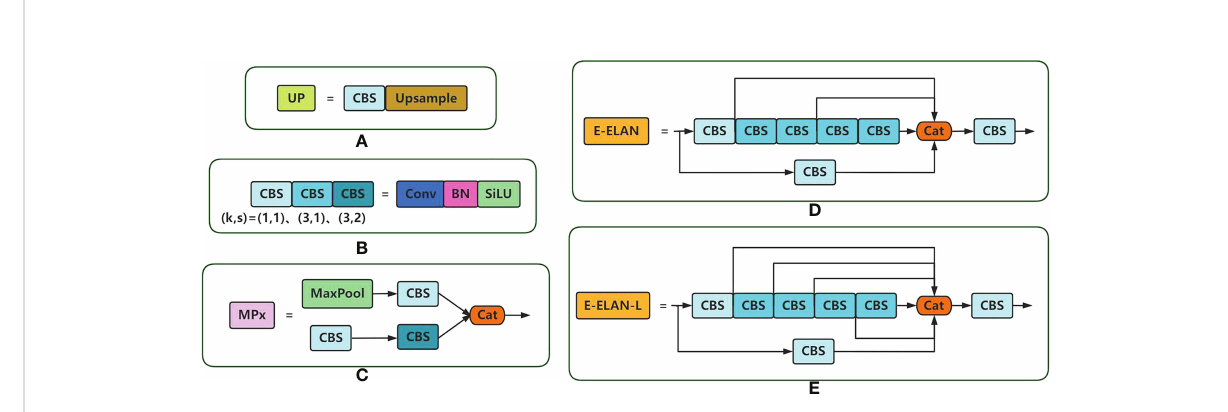
FIGURE 2 Structure diagram of the model part of the module. Where (A) denotes the upsampling module, (B) denotes the composition of different convolution modules, where k denotes the size of the convolution kernel and s denotes the convolution step size, (C) denotes the basic structure of the MP module, (D) denotes the basic structure of the E-ELAN module, and (E) denotes the basic structure of the E-ELAN-L module.